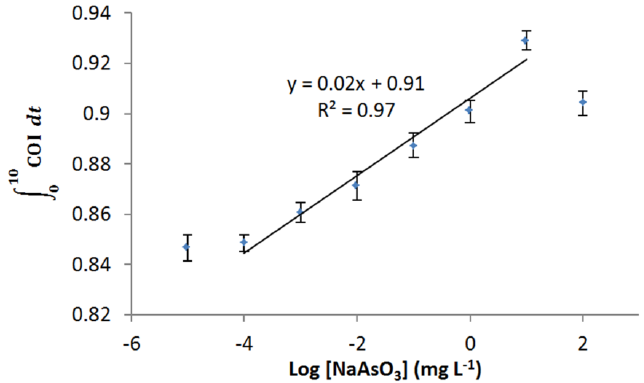
Figure 5. Dynamic range of E. coli roGFP2 oxidative stress biosensor towards NaAsO 3 10 exposure (10 ng·L −1 –100 mg·L −1 ). ∫ COI 𝑑𝑡 indicates the total COI response of biosensor 0